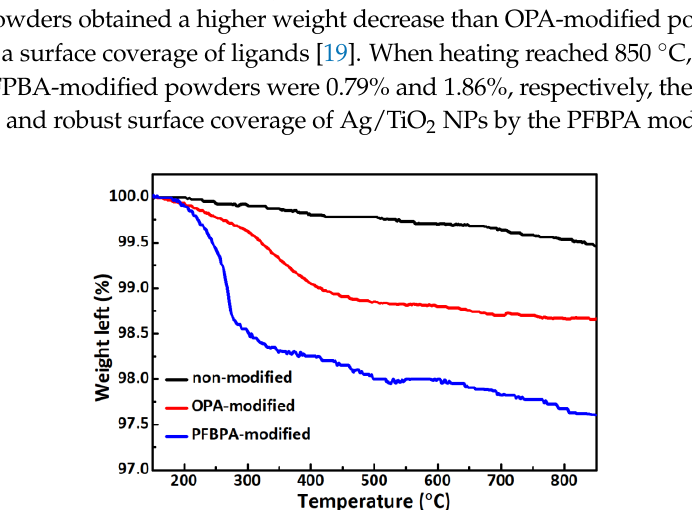
Figure 4. Thermogravimetric analysis of non-modified, OPA-modified, and PFBPA-modified Ag/TiO 2